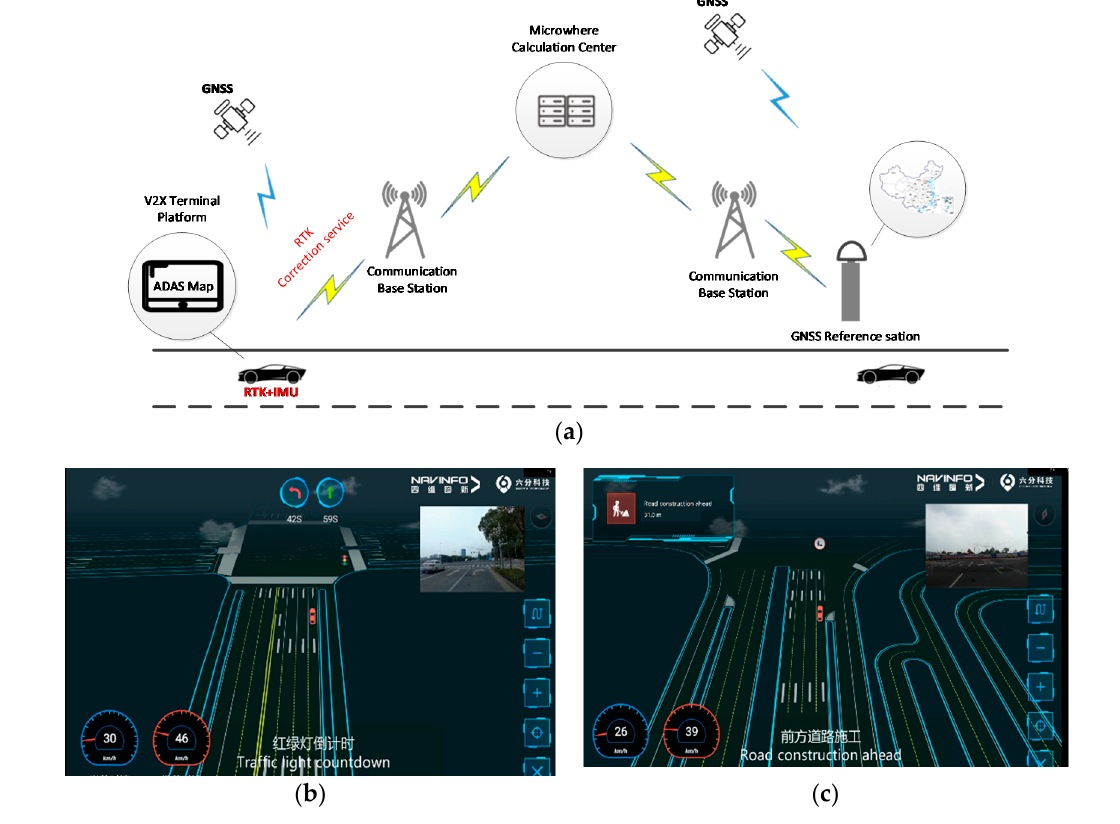
Figure 15. RTK + IMU integrated positioning solution. Table 3. Key KPIs of Testing and Typical Application